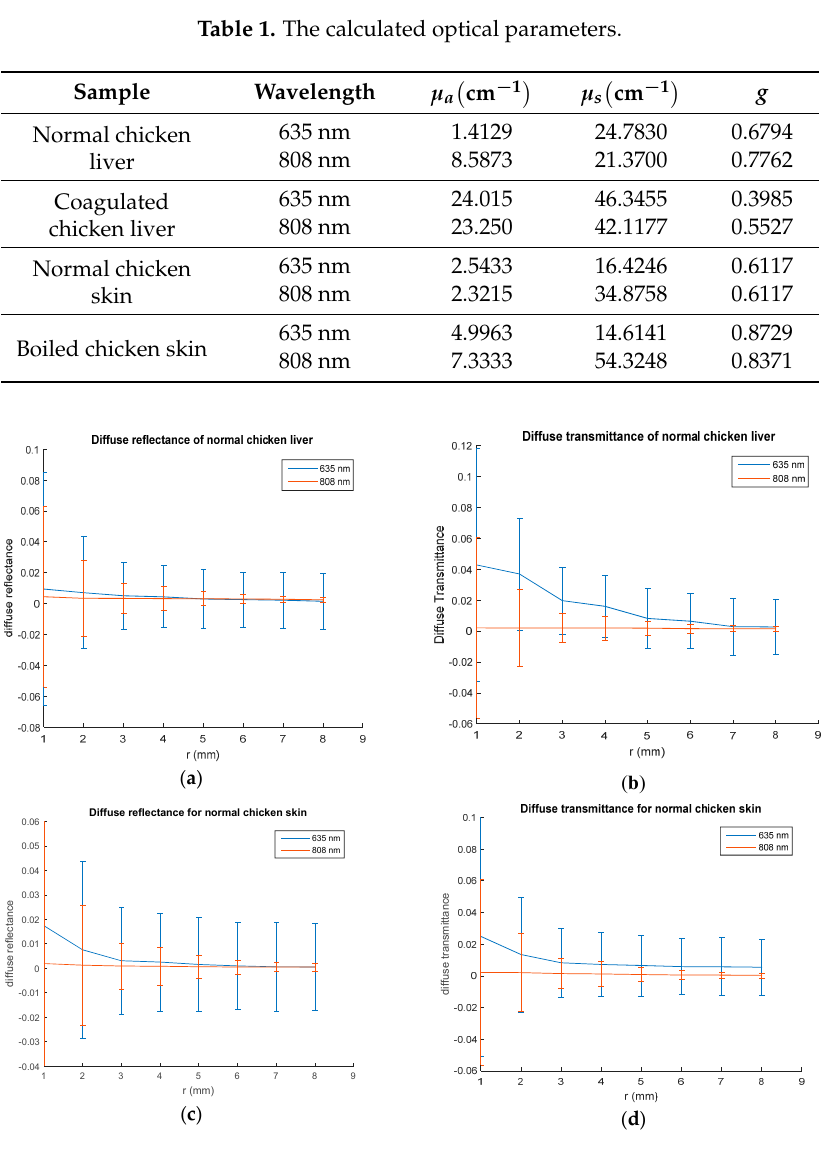
Figure 3. Spatially resolved steady state of: ( a ) diffuse reflectance of normal chicken liver; ( b ) diffuse transmittance of normal chicken liver; ( c ) diffuse reflectance of normal chicken skin; ( d ) diffuse transmittance of normal skin.